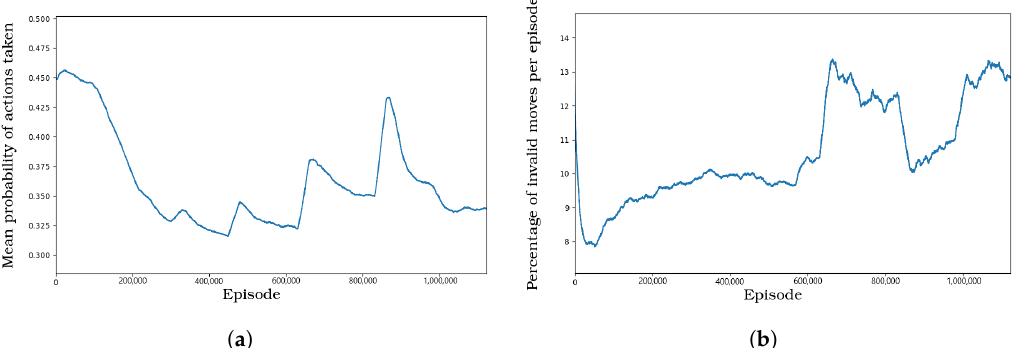
Figure 9. ( a ) The mean value of the probability of chosen action. ( b ) The percentage of invalid moves in the episode. The values of the mean probability are significantly smaller than in the A2C implementation—which is a result of improvements caused by the usage of PPO. We can observe a much slower and steadier increase—in this case, the certainty does not go up so drastically, which is beneficial for additional exploration of the environment.